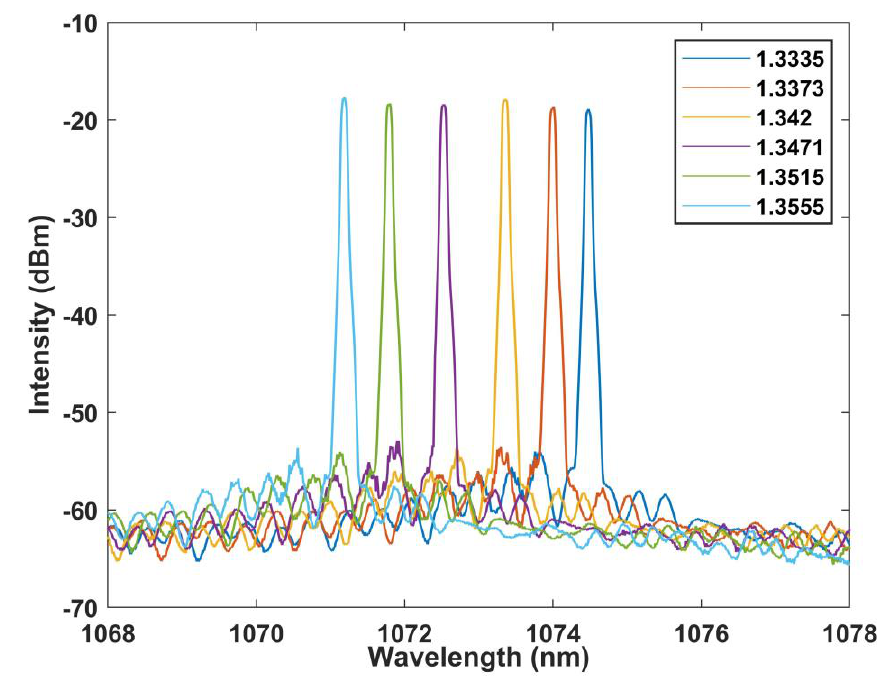
Figure 13. Wavelength versus RI curve at FRL.